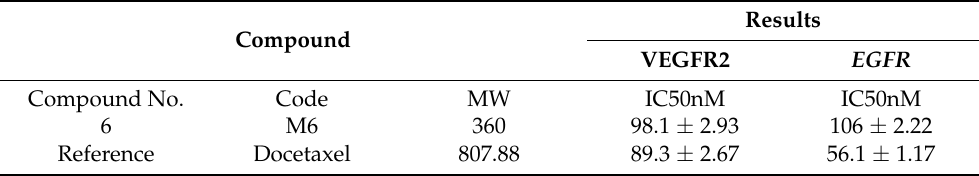
Results VEGFR2 EGFR